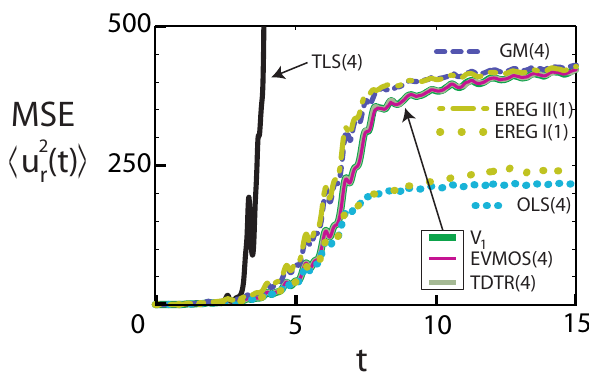
1 Fig. 4. The short-time mean square error (MSE) evolution for the Lorenz model with large model error ( (cid:14)r = 10 (cid:0) 2 ) and with 5 (cid:2) 10 5 ensembles of 500 members. The lines indicated with “1 predictor” and “4 predictors” apply to all regression methods except for GM and EREG II.